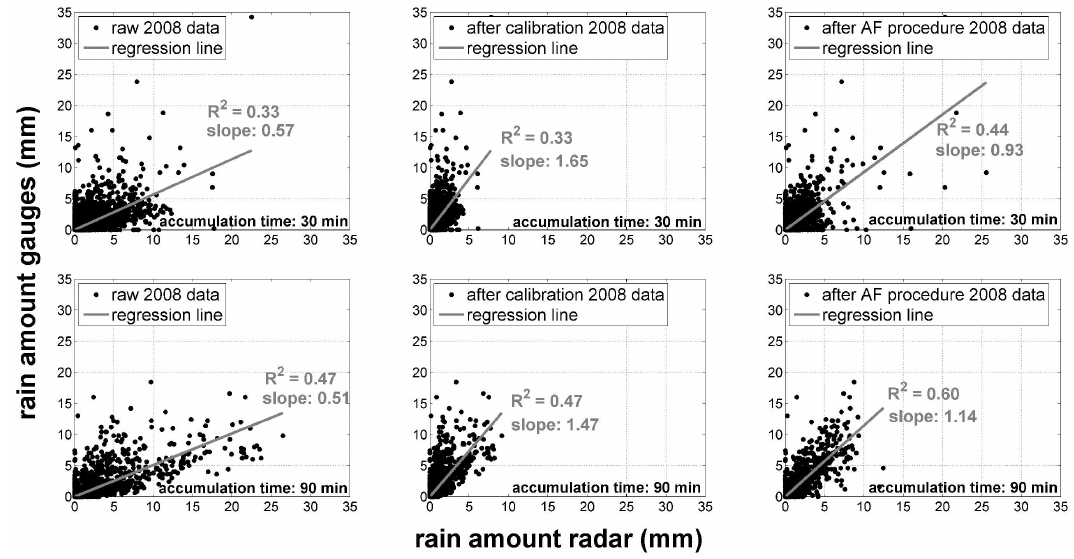
Fig. 15. Scatter plots of rainfall time series’ pairs, obtained during 2008 by Polar 55C and by each rain gauge located beyond a distance of 40km from radar. These refer to a time aggregation of 30 and 90 min (upper panels and lower panels, respectively) for the initial data sets (left panels), after calibration (middle panels) and after the adjustment procedure (right